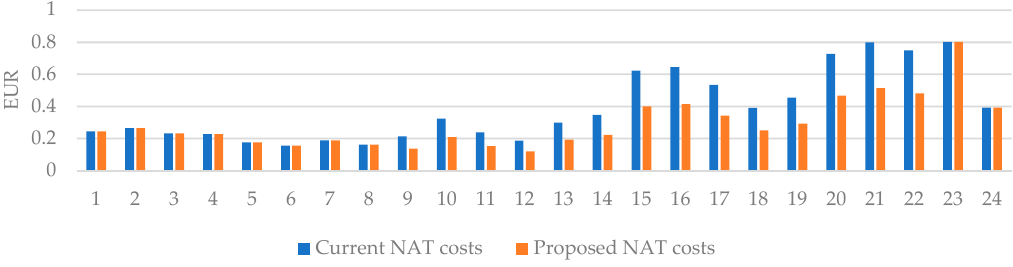
Figure 6. Comparison between the sum of hourly NAT costs for a flat rate in a BaU scenario and in the proposed business model during the 6-month trial period. Source: Authors’ own elaboration .